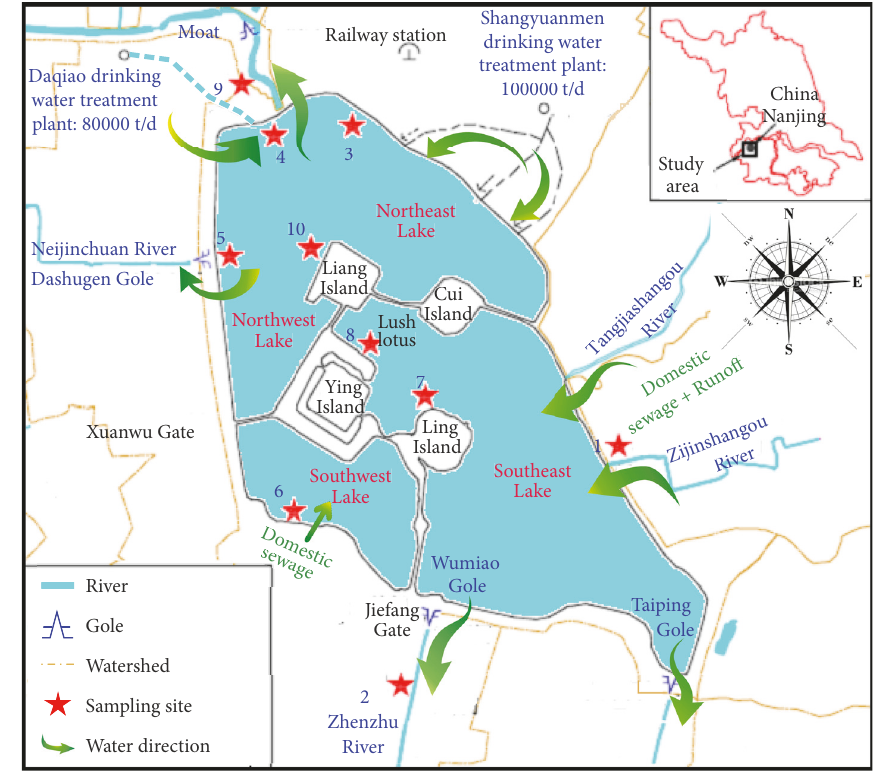
Figure 1: The schematic diagram of sampling